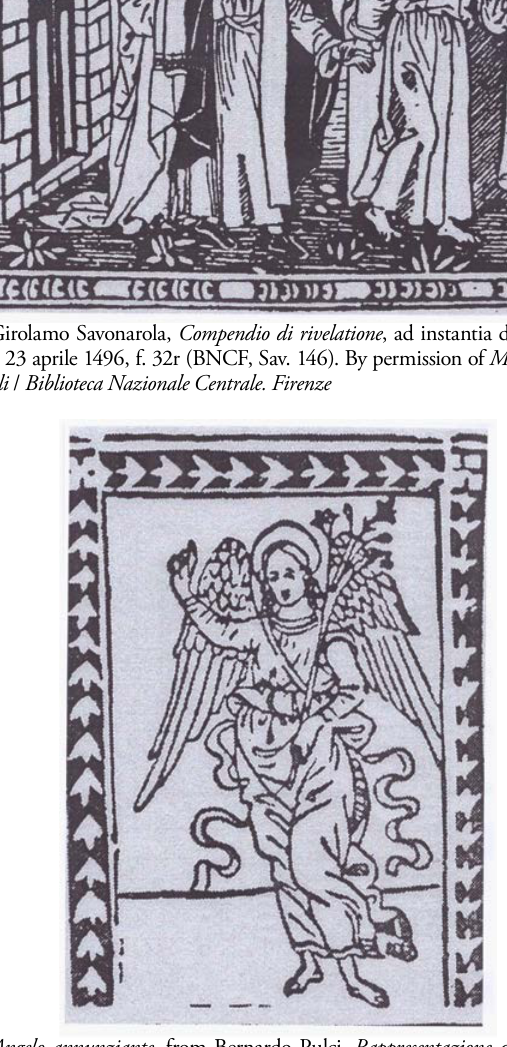
Figure 13 – Angelo annunziante , from Bernardo Pulci, Rappresentazione di Barlaam et Iosafat , [Firenze, Miscomini, around 1495], f. a1r (BNCF, Banco Rari 189.e). By permission of Ministero per i beni e le attività culturali / Biblioteca Nazionale Centrale. Firenze